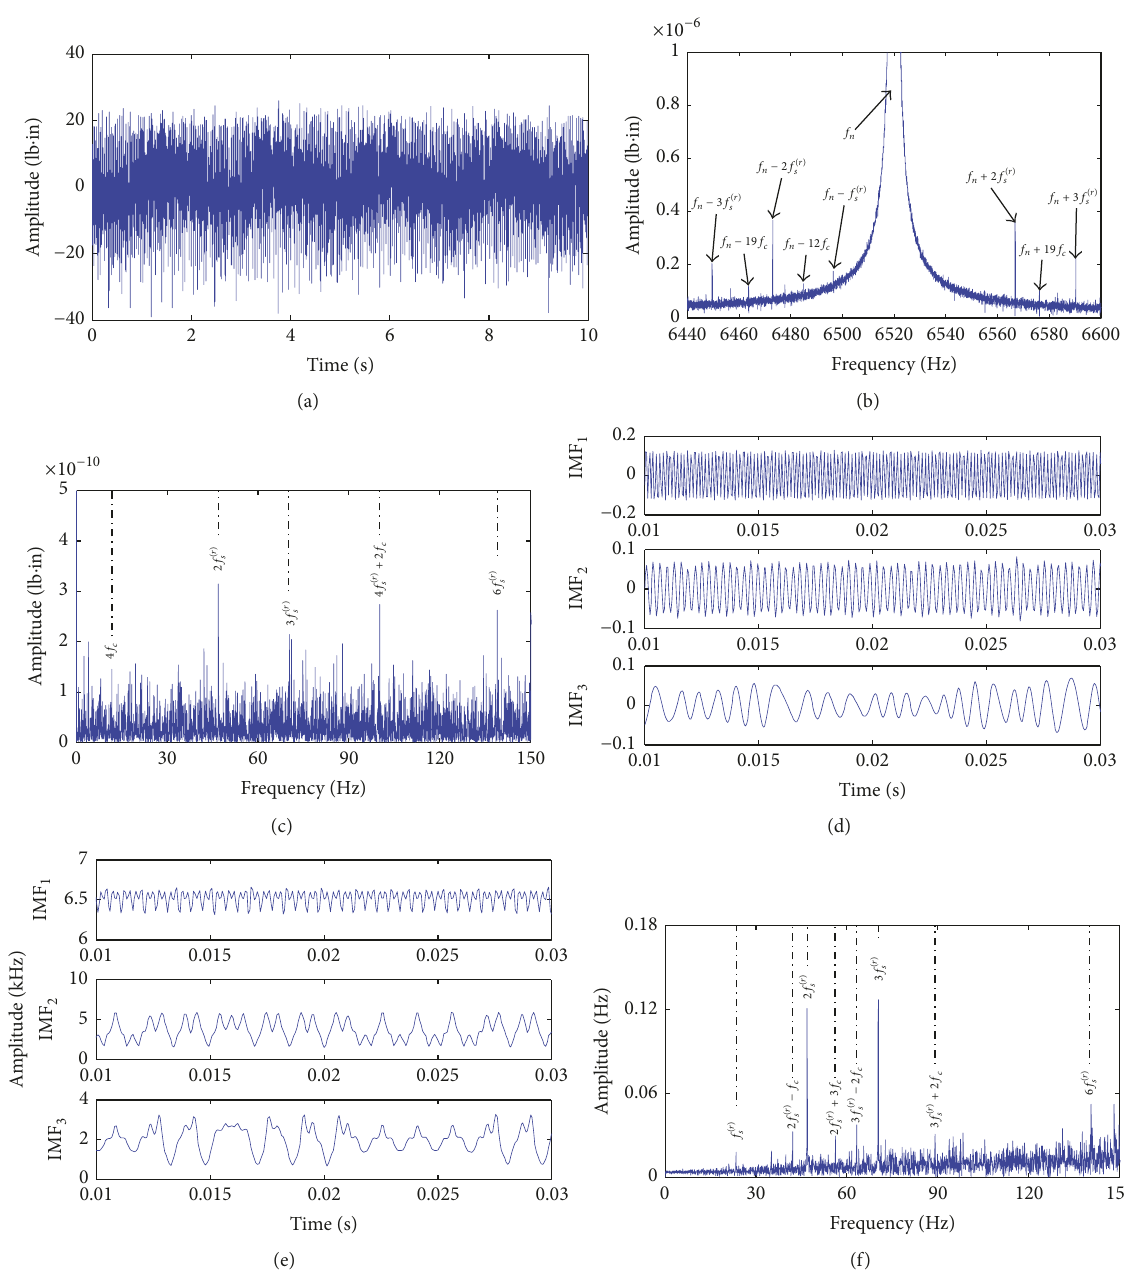
Figure 9: Baseline signal analysis: (a) detrended torsional vibration signal, (b) Fourier spectrum, (c) envelop spectrum, (d) IMFs, (e) instantaneous frequencies of IMFs, and (f) Fourier spectrum of instantaneous frequency.